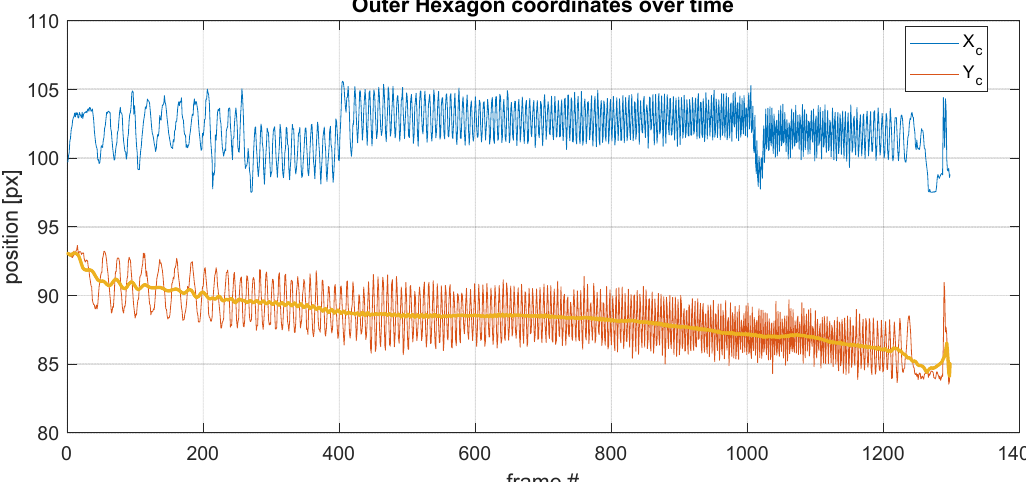
Figure 9. Outer hexagon coordinates over time (frame index). The moving average of the estimated parameter Y c is added in yellow. N.B., The selected y coordinate ranges from the top to the bottom of the displayed image (e.g., in Figure 6), differently from the standard.